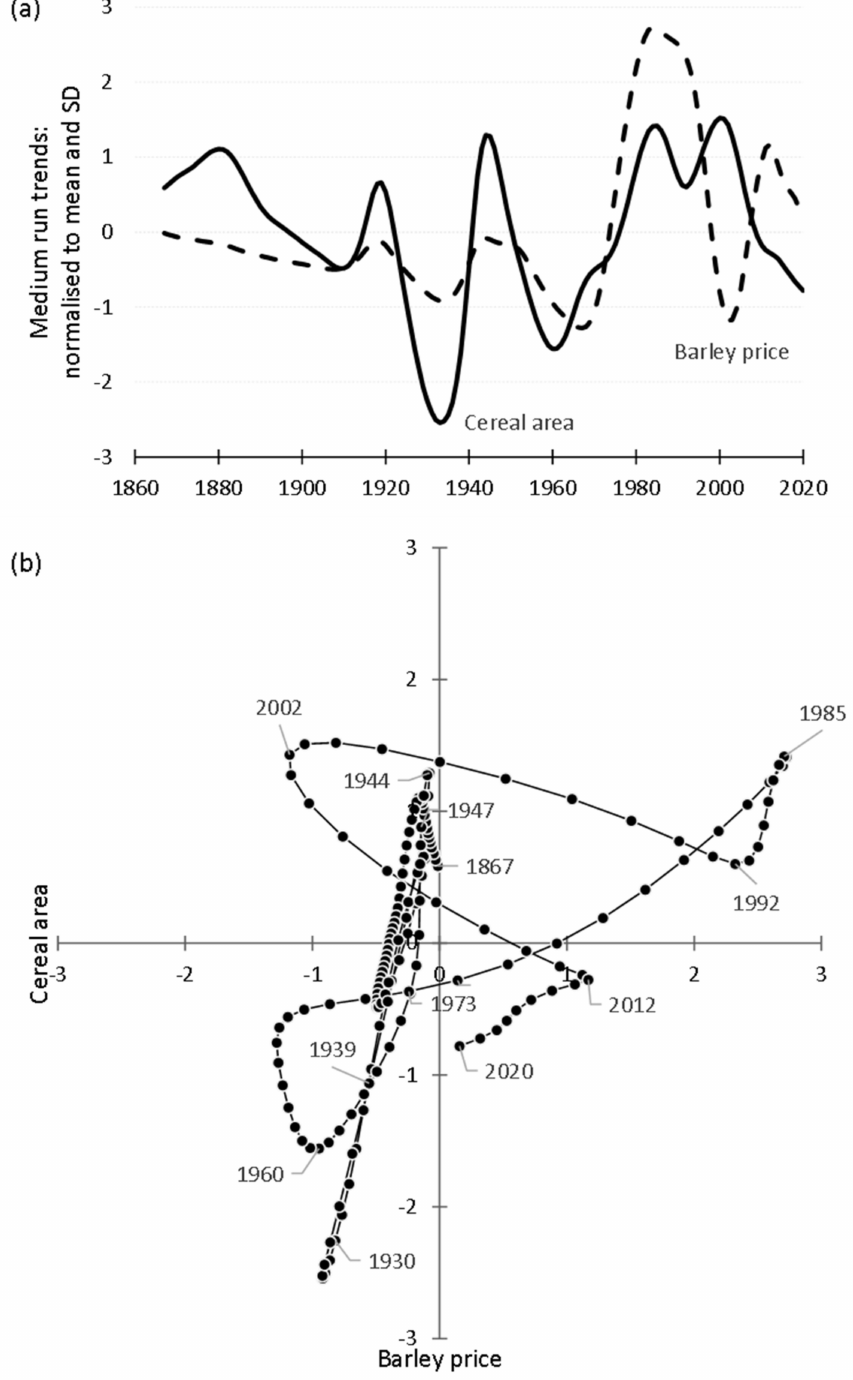
Figure 7. Medium-term patterns of variation for barley price and cereal area in Scotland (1867–2020) as ( a ) time series and ( b ) phase plots. Note: the variables are normalized to account for differences in